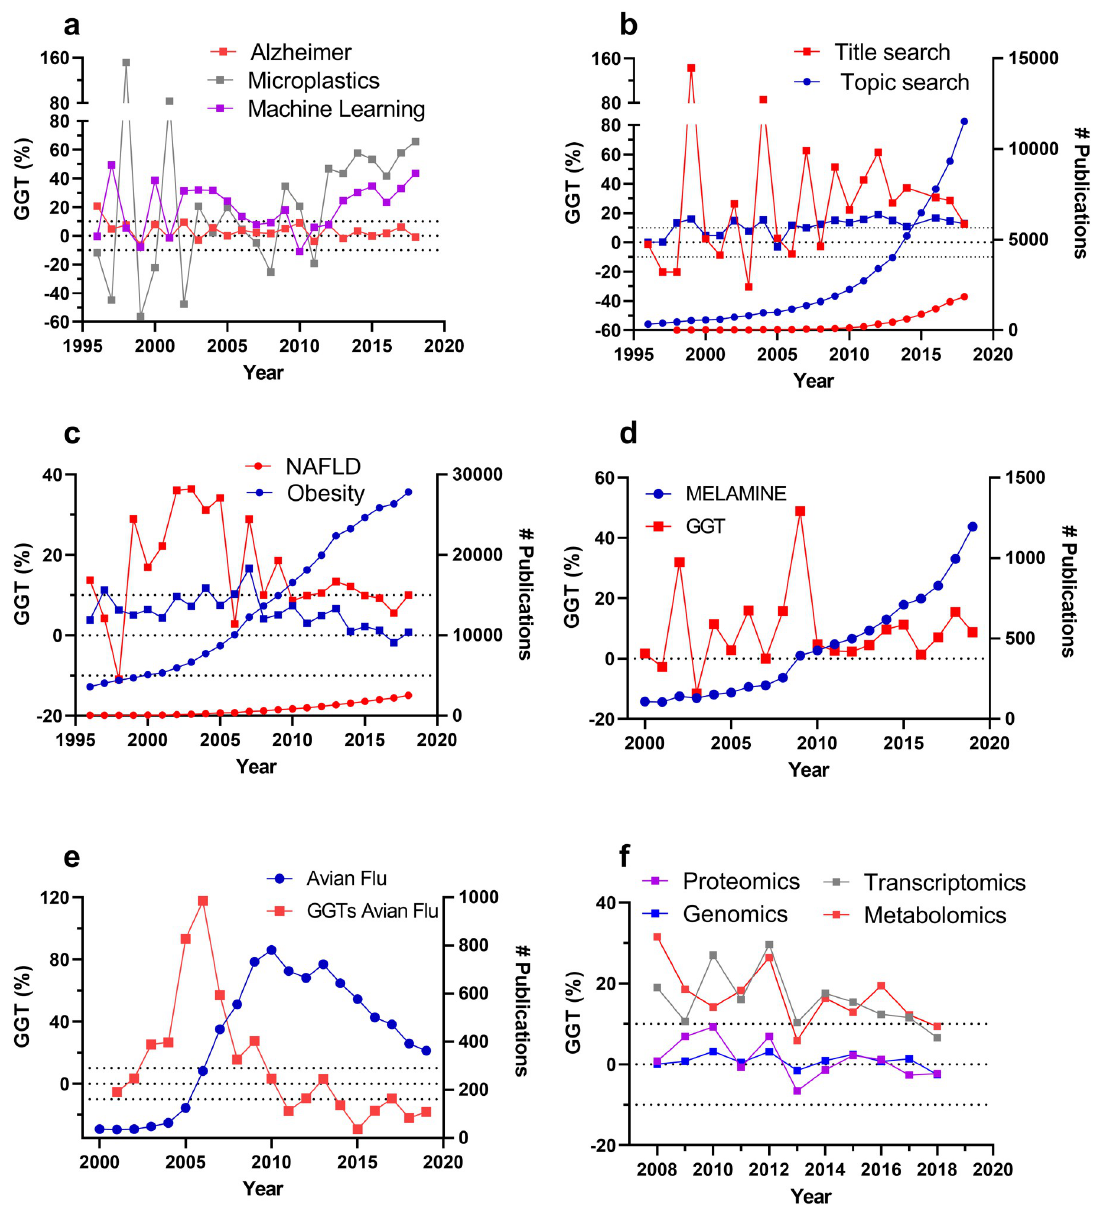
Fig 4. Trend analyses of publication trends on various life science fields. a) GGTs for the fields Alzheimer’s, microplastics and machine learning. b) GGTs (squares, left y-axes) and publication trends (circles, right y-axes) for the field microbiome using either a title search (red) or a field search (blue). c) GGTs (squares, left y-axes) and publication trends (circles, right y-axes) for the fields NAFLD and obesity. d) GGTs (red squares; left y-axes) and publication trends (blue circles; left y-axes) for melamine research. e) GGTs (red squares; left y-axes) and publication trends (blue circles; left y-axes) for the field avian flu (H5N1). f) GGTs for various omics techniques. All field searches were conducted in WoS excluding the ESCI index. Search strings and raw data used are given in the S2 File.